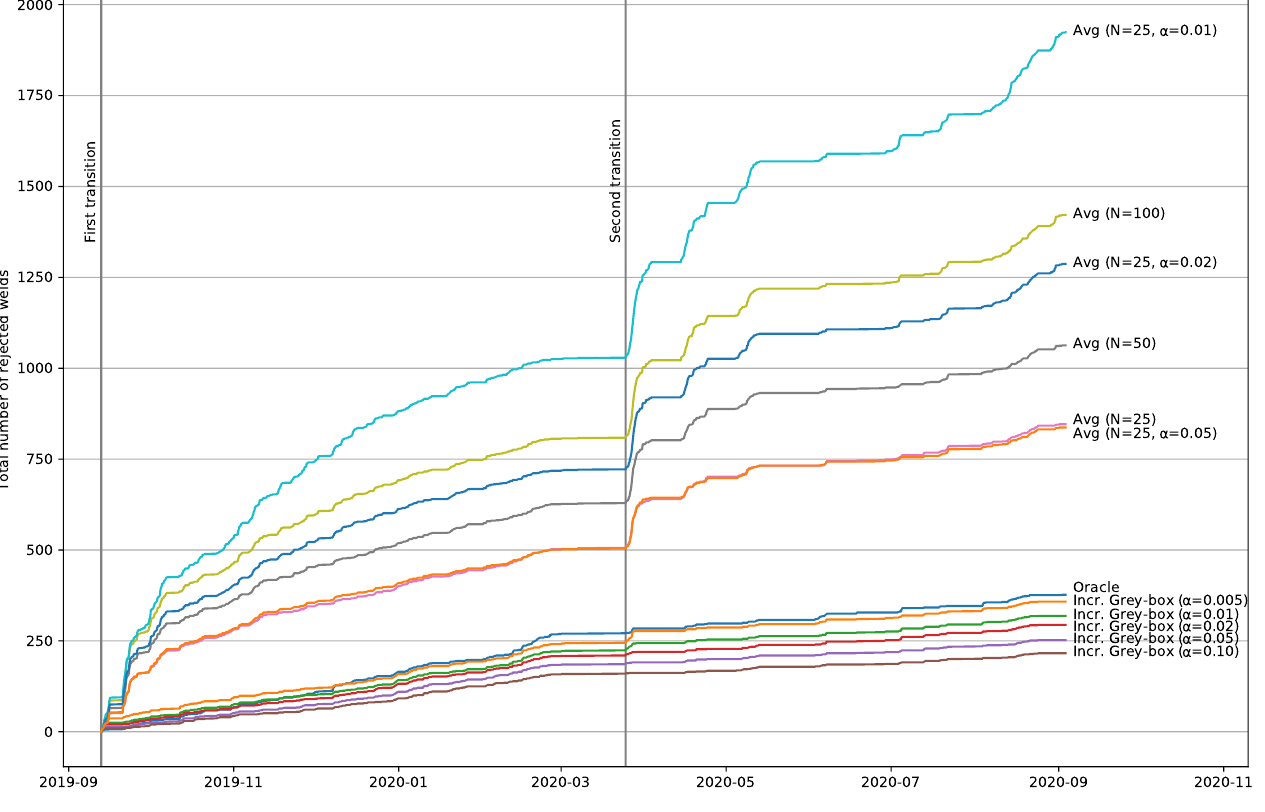
Figure 4. Cumulative number of rejected welds (on a total of 15,231 welds) over time for models trained exclusively on data before the first transition, except for the oracle model, which was trained on all weld data. Welds are rejected when the prediction error is larger than 3%. The average-based models have noticeable jumps after both transition periods; the timings of the jumps can be attributed to batches that require different welding programs. The incremental models only exhibit minor jumps from this